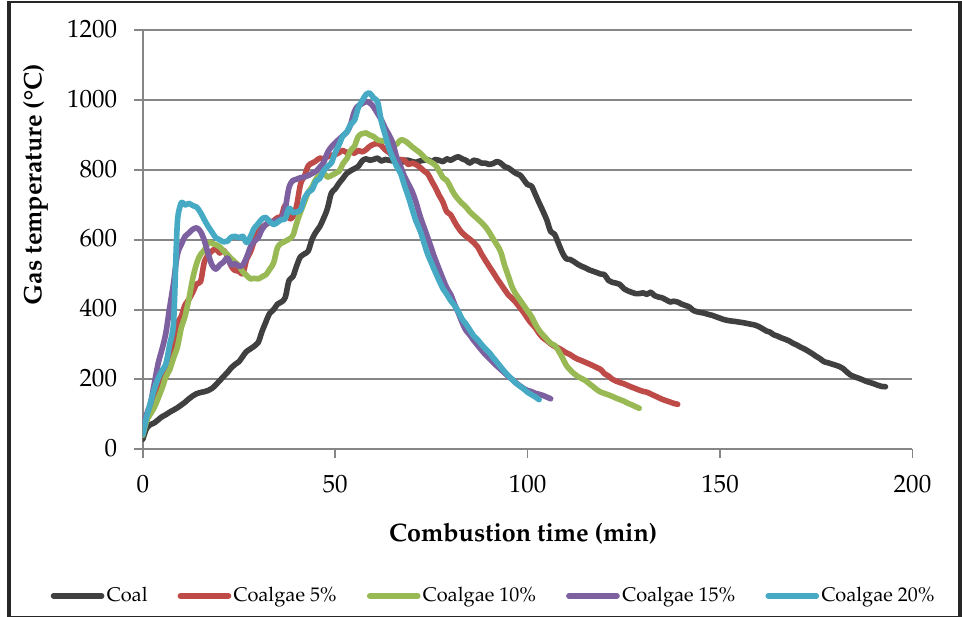
Figure 3. Flue gas temperature at the reactor exit.